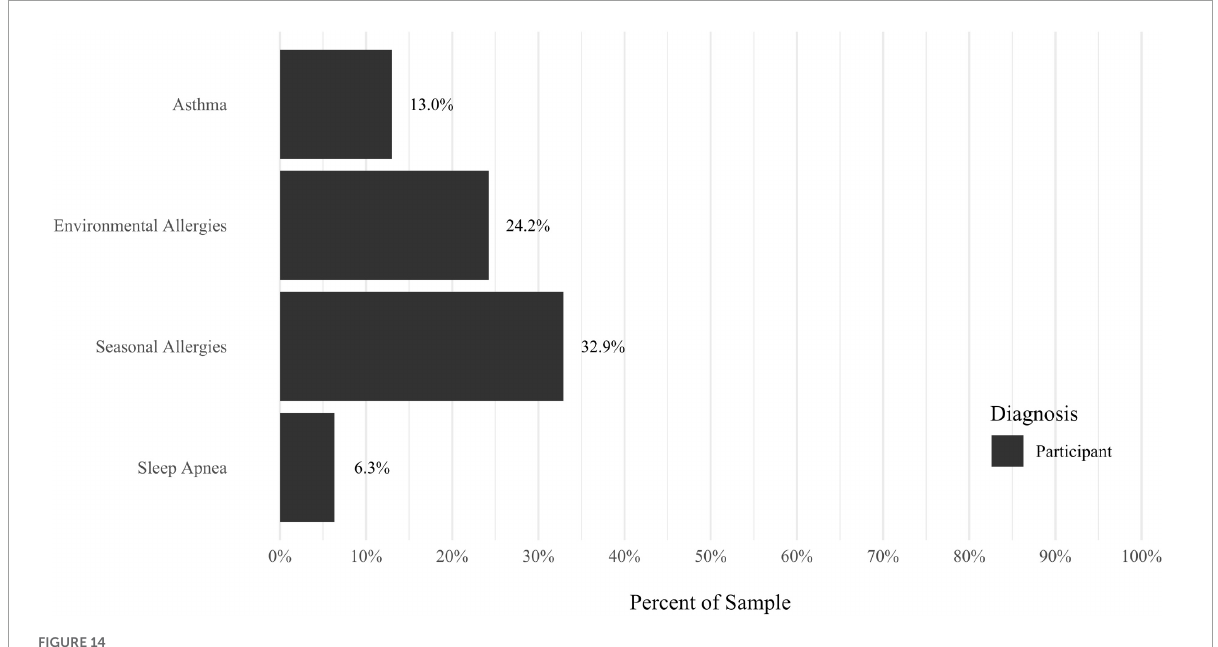
FIGURE14 Rates of medical health problems: lung problems.